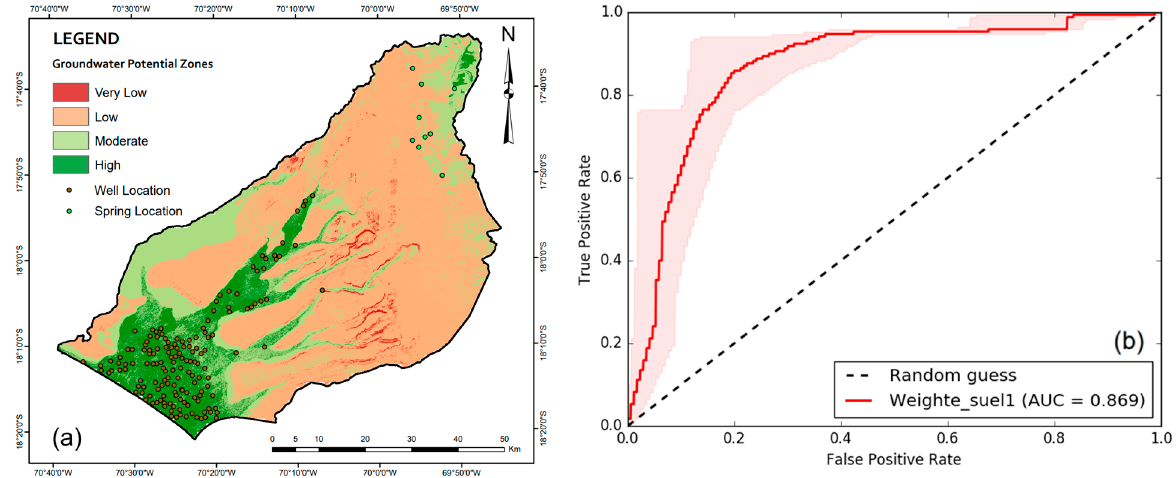
Figure 6. ( a ) Well and spring locations used for the model validation. ( b ) Receiver Operating Characteristic (ROC) curve for groundwater potential map validation.